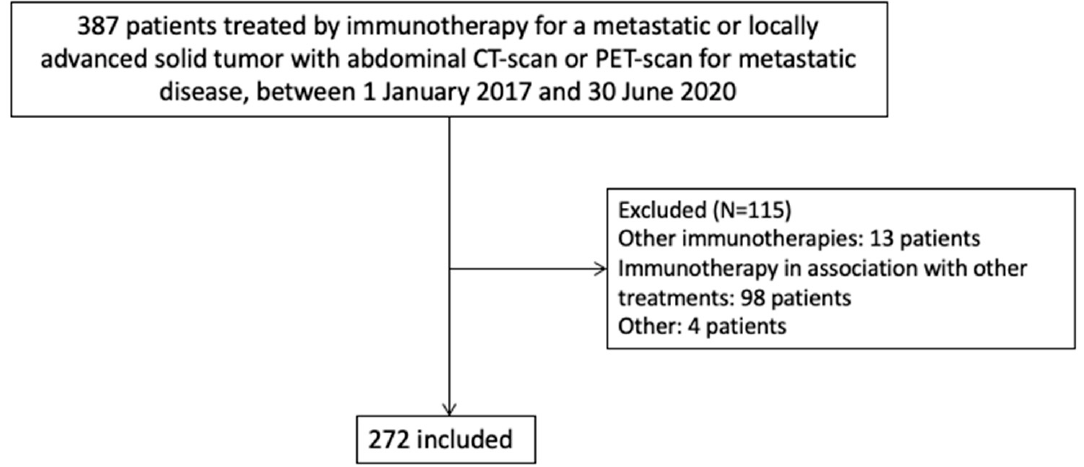
Figure 1. Flow chart of the study population ( n = 272). Median age at the start of immunotherapy for the patients included was 61.4 years, and 64% of the patients were men (Table 1). Menopausal status was not reported, but only 19 of the female patients were under the age of 50 years. More than 60% of the patients ( n = 179) had a BMI < 25, whereas 34.2% ( n = 93) had a BMI ≥ 25. The most frequent type of cancer was NSCLC, in about half the population ( N = 136), followed by head and neck carcinoma in 13.2% ( N = 36), and gastrointestinal cancer, renal carcinoma and melanoma, each in 8.5% ( n = 24, n = 24 and n = 22, respectively). PDL-1 expression status was positive (>1%) in 75.4% ( n = 104) of the tumors tested ( n = 138). Overall, 9% ( n = 24) of the tumors were MSI-H; 88% of patients ( n = 239) received monotherapy, with nivolumab in 41.9% ( n = 114) and pembrolizumab in 37.9% ( n = 103). Performance status (PS) at the initiation of immunotherapy was ≤ 1 for 79% ( n = 215) of patients. In total, 141 toxicity events were reported, in 41.2% of patients ( n =